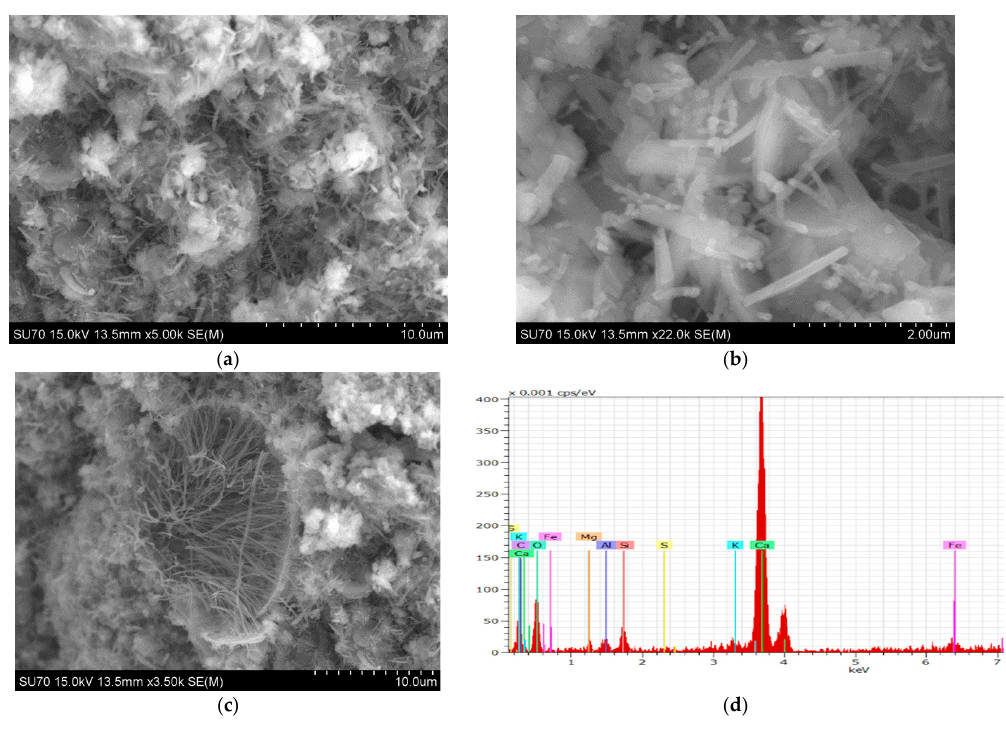
Figure 5. ( a – c ) SEM micrograph of 3_NCPV, ( d ) EDS spectrum of the needle ‐ shaped particles.